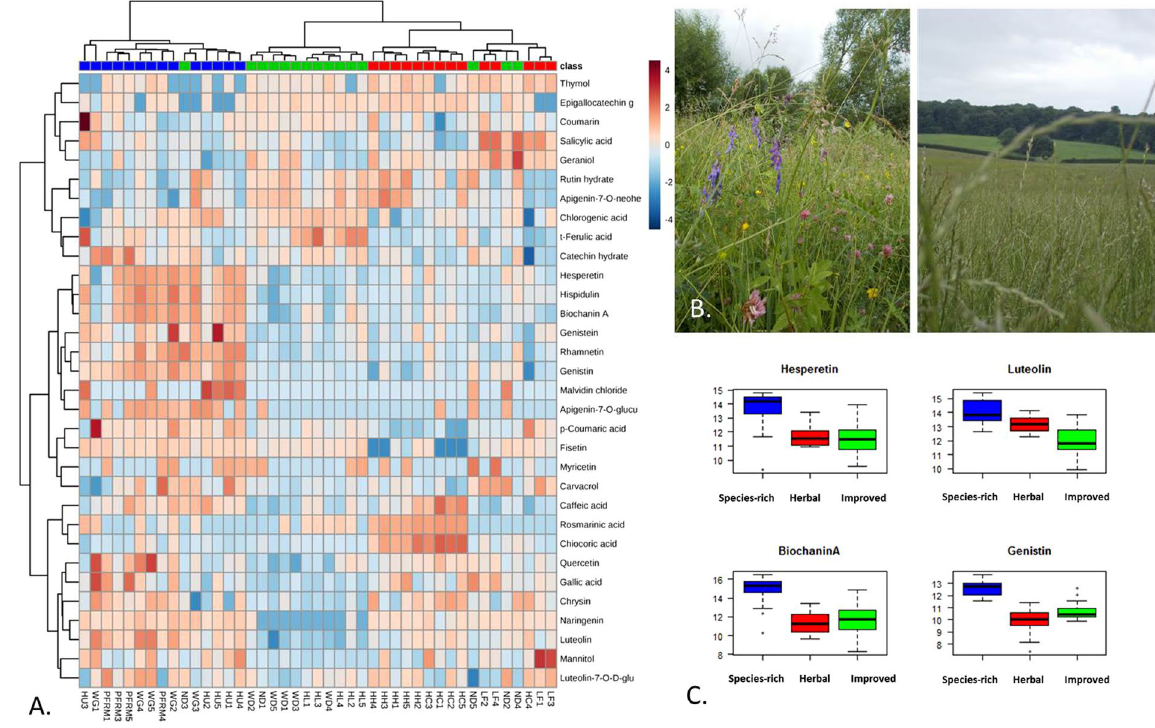
Figure 4. Species-rich grasslands are a hotspot for antimicrobial compounds. ( A ) Heat map of the 31 antimicrobial and anthelmintic compounds found in the mixed forage samples based on Euclidean distances and Ward clustering. ( B ) Comparison of vegetation characteristic of species-rich grasslands (left) and improved grasslands (right). ( C ) Example compounds significantly more abundant in species-rich grasslands. Compound concentrations are represented on a log